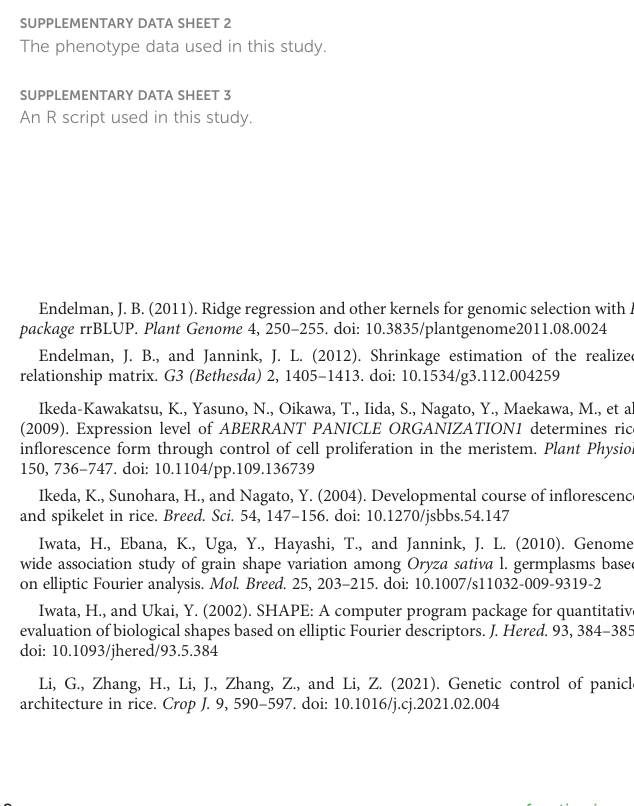
SUPPLEMENTARY DATA SHEET 1 The genotype data used in this study. SUPPLEMENTARY DATA SHEET 2 The phenotype data used in this study. SUPPLEMENTARY DATA SHEET 3 An R script used in this